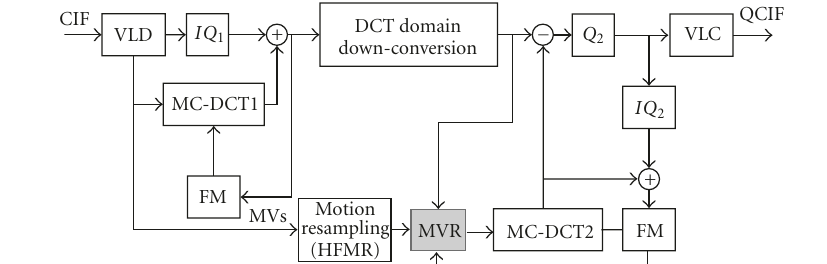
Figure 12: The architecture of CDDT with MVR.